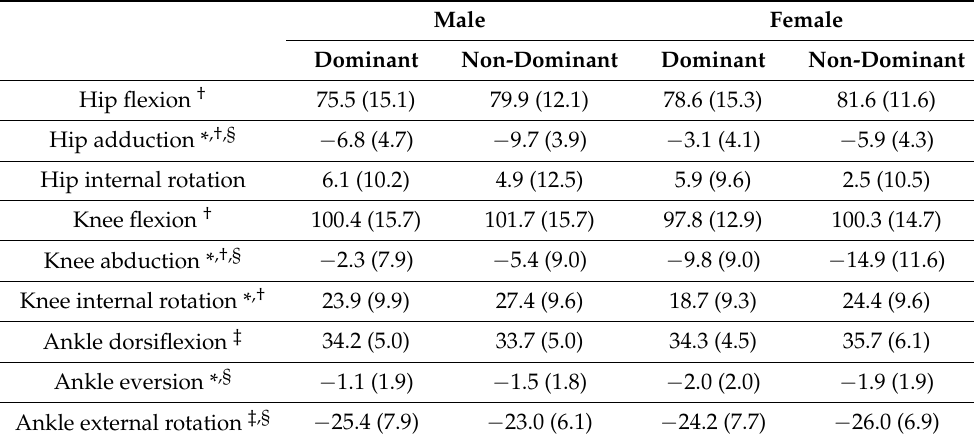
Table 4. Peak lower extremity angles during a